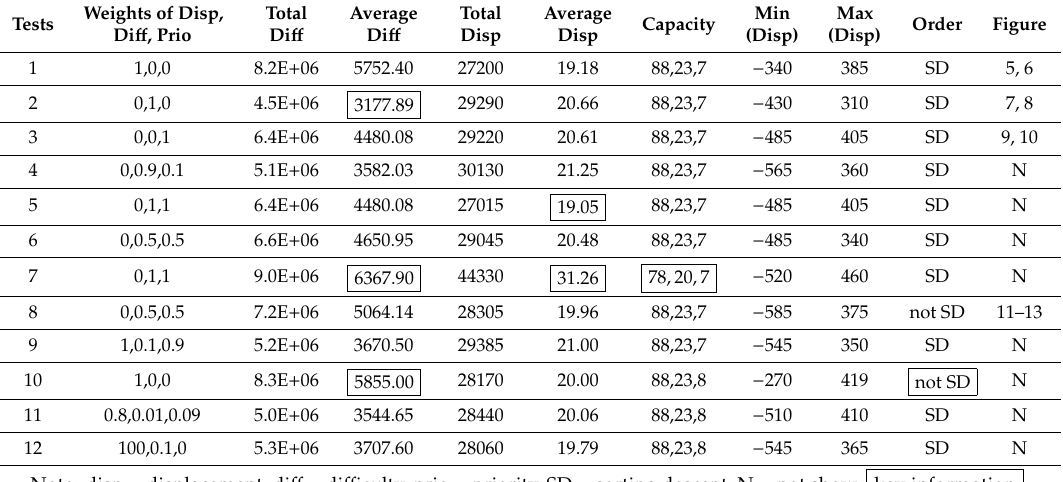
Table 4. Performance compare with di ff erent weight factors of evaluation